Question: Draft a figure caption describing what is shown.
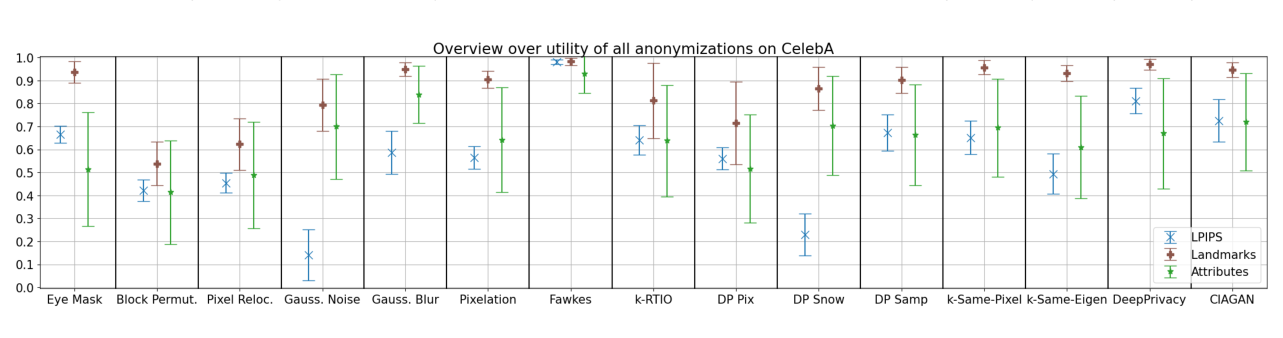
Answer: Mean utility and 95% confidence interval via perceptual similarity (LPIPS), attribute similarity, and landmark similarity for all anonymizations; on 300 identities of CelebA.